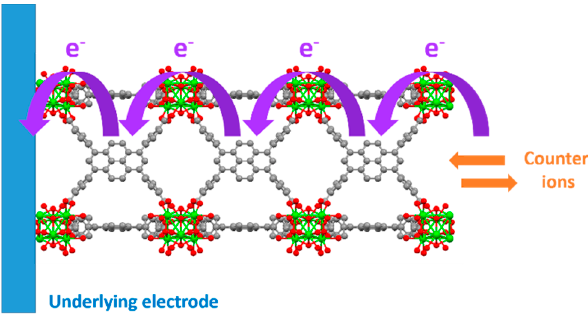
Figure 2. Charge transport via redox hopping between the pyrene units presented in one-dimensional channels of the NU-901 thin film [37].